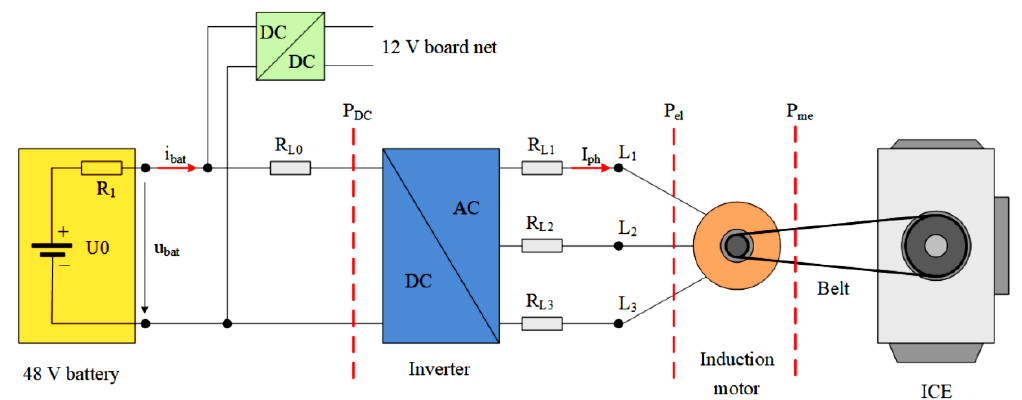
Figure 3. A 48-V DC electrical architecture in P0 configuration [10].